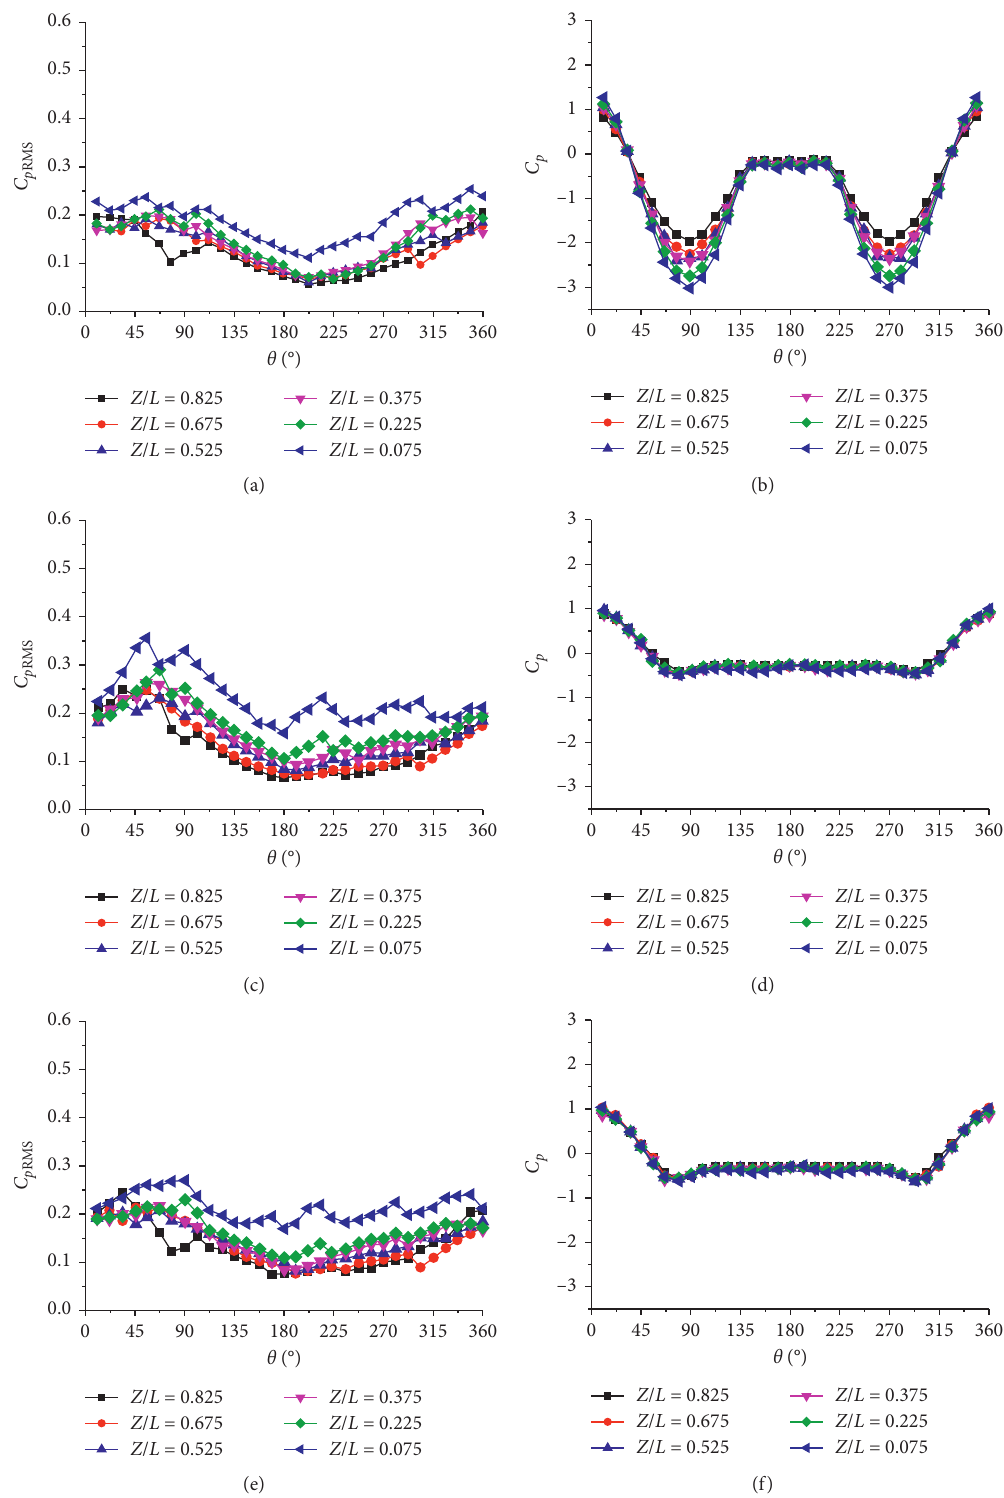
Figure 11: Effect of measurement point height on the fluctuating and local mean wind pressure coefficient. (a, c, e) Type A turbulent flow field and (b, d, f) uniform flow. (a, b) c � 0, (c, d) c � 0.0386, and (e, f) c �